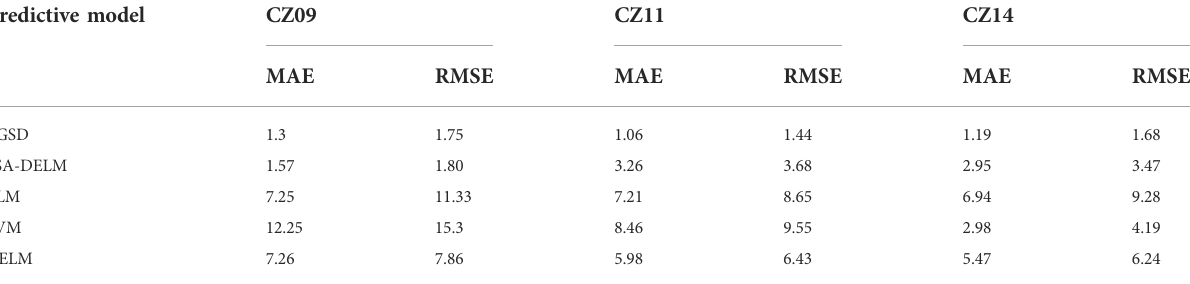
TABLE 4 Comparison of errors of different prediction models. Predictive